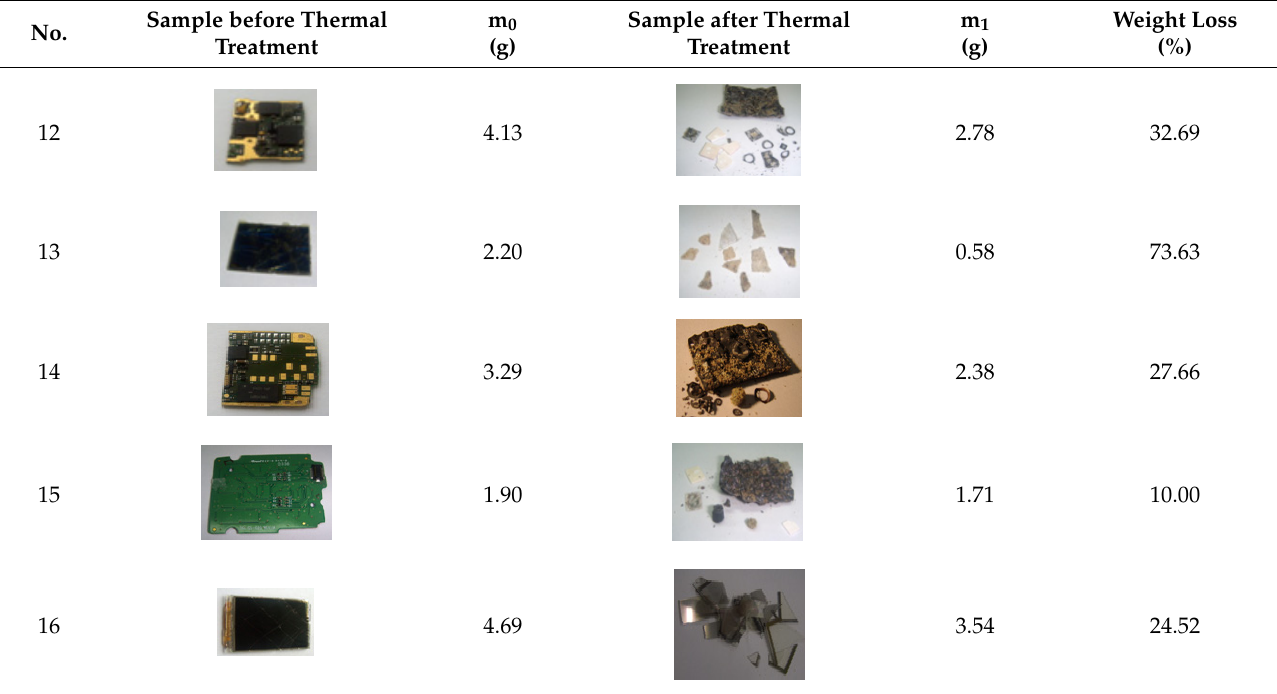
Table 3. Samples of the mobile phone waste from 12 to 20 before and after thermal treatment in the fluidised bed and their weight losses.